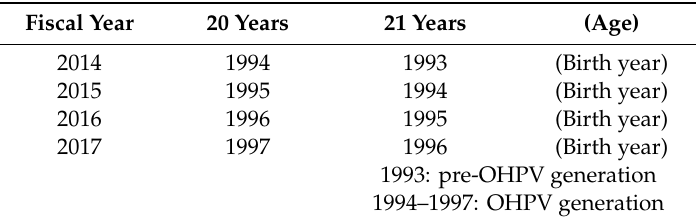
Table 1. Target group in this